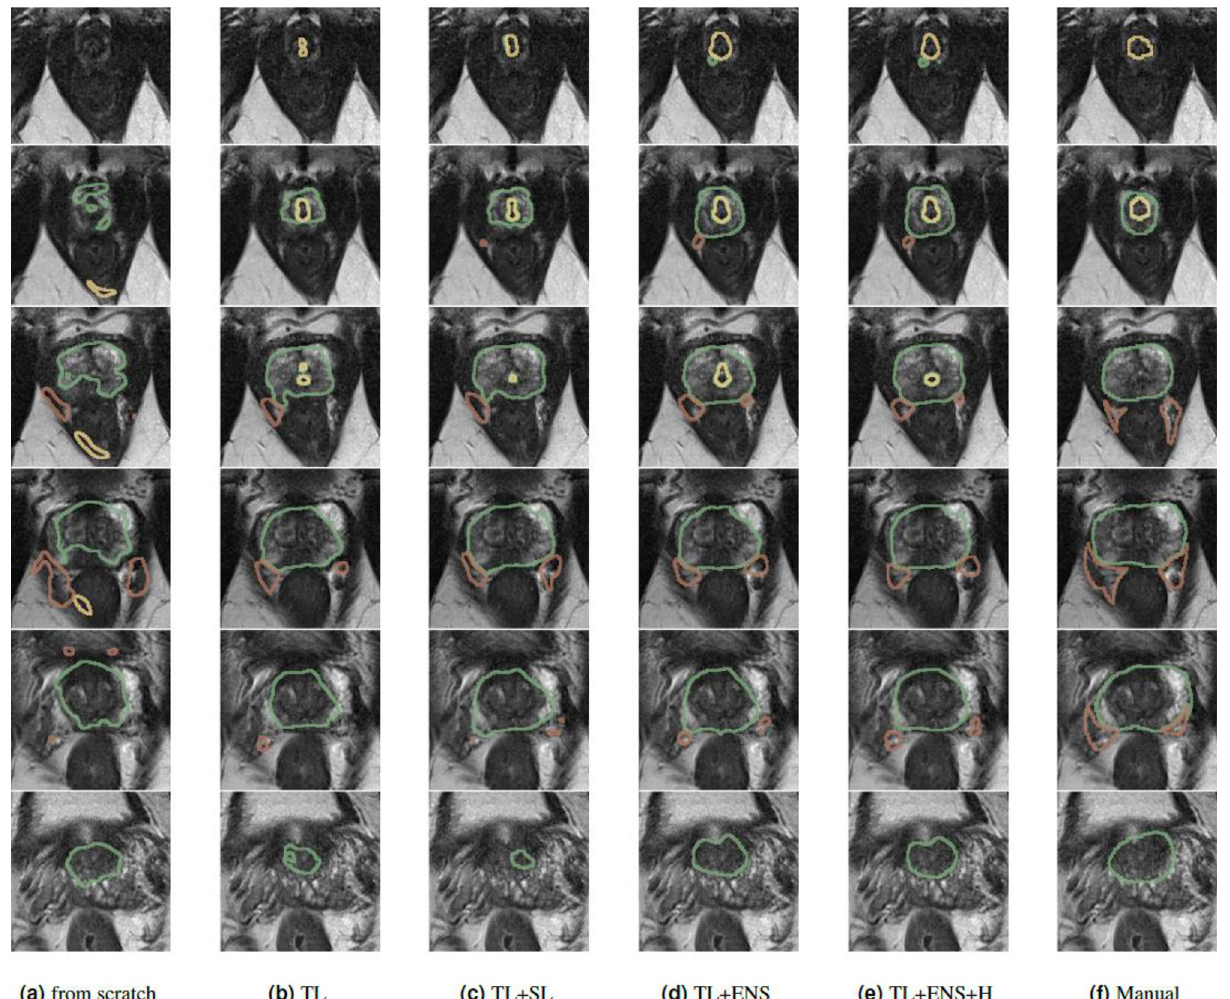
Figure 5. Example segmentation result of one case for the discussed approaches. The quality of segmentation improves over the added features of our method. The DC for TL + ENS + H approach is 0.817 and 0.726 for training from scratch. For the EUS the DC is 0.706 and 0.0, respectively. NVB obtains a DC of 0.392 for training from scratch and a DC of 0.488 for the proposed TL + ENS + H approach.The training for the CNNs applied to this case was run with n = 5 images.